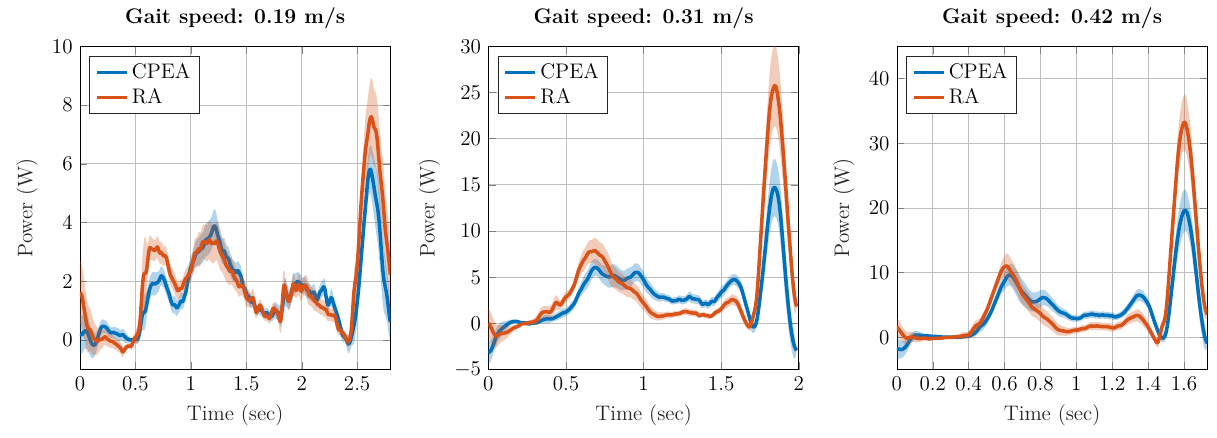
Figure 15. Power for the hip joint at three different gait velocities for an RA and